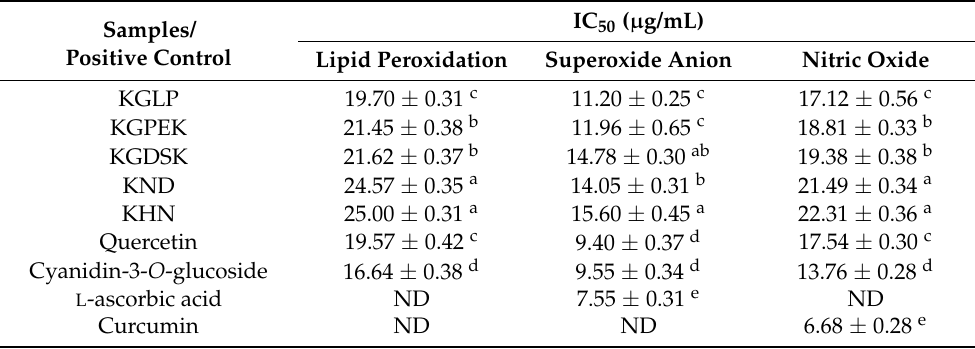
Table 3. IC 50 on inhibition effect on lipid peroxidation, nitric oxide, and superoxide anion scaveng- ing